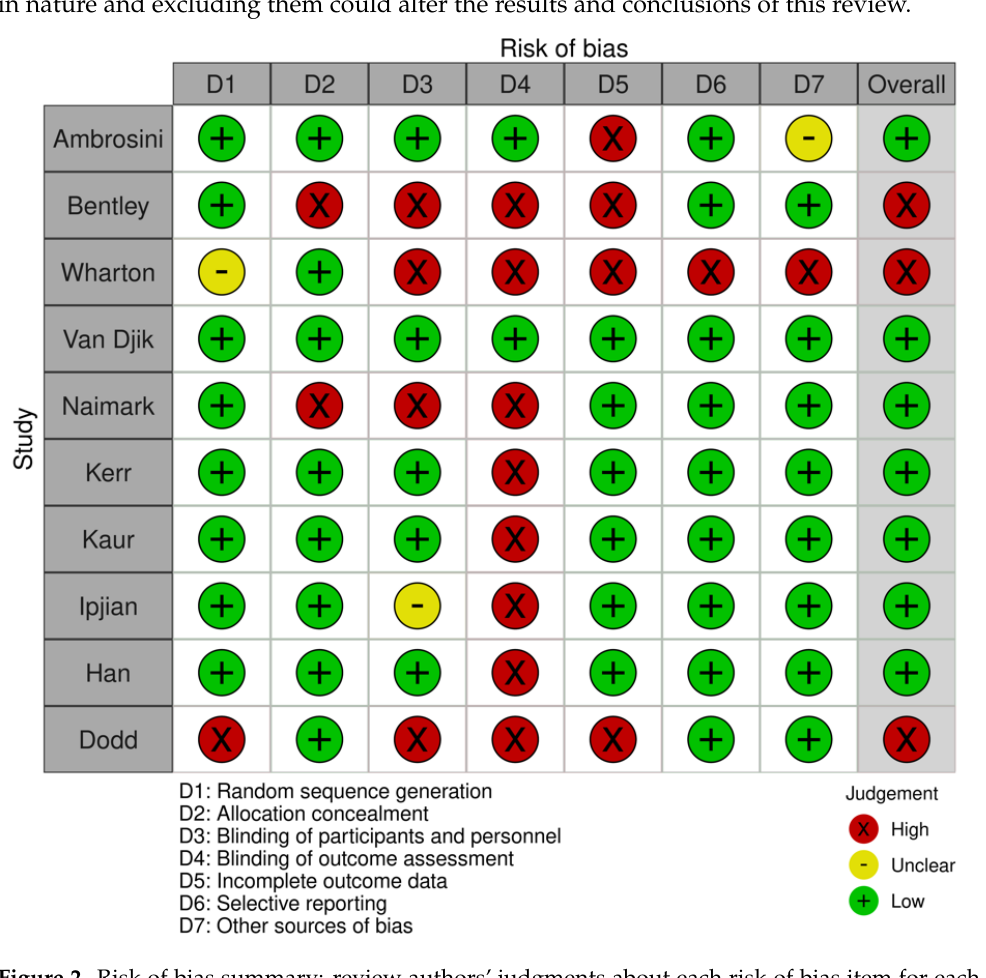
Figure 2. Risk of bias summary: review authors’ judgments about each risk of bias item for each included study.